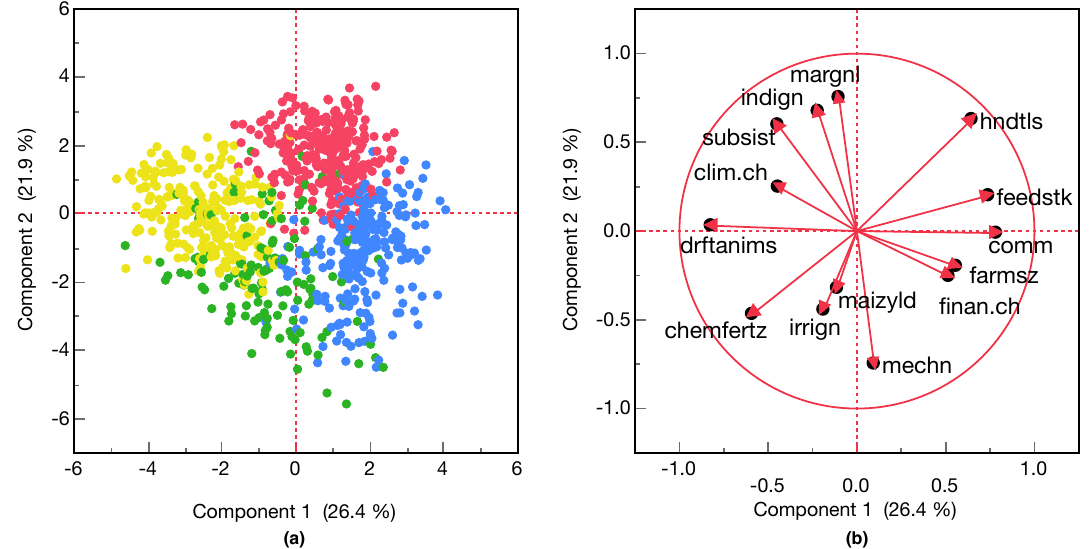
Figure 1. ( a ) Score plot of first two principal components colored by farm type clusters (see also Figures 2 and 3); ( b ) Loading plot of first two principal components illustrating relationships among farm characteristic variables. Colors refer to the four clusters (see also Figures 2–4).